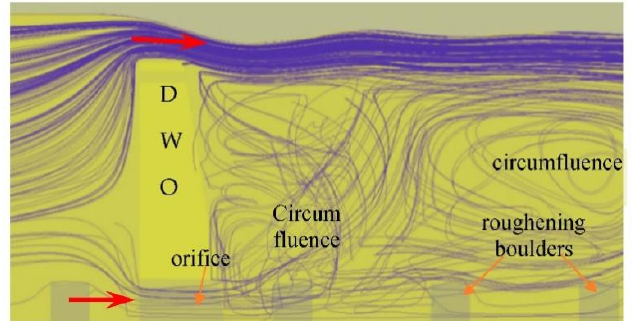
Figure 18. Streamlines through the DWO plate. The change in the streamline distributions around the roughening blocks at the bottom reflects their retardation effect and the adjustment to the bottom flow field. The streamlines show that there is still circumfluence between the two weirs.